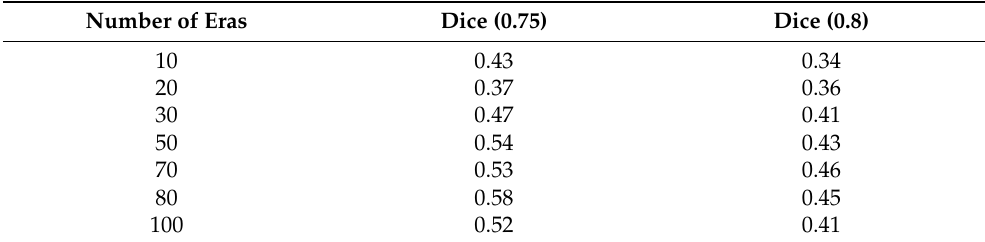
Table 2. Comparison of the average Sørensen–Dice coefficient scores for different partitions of the original